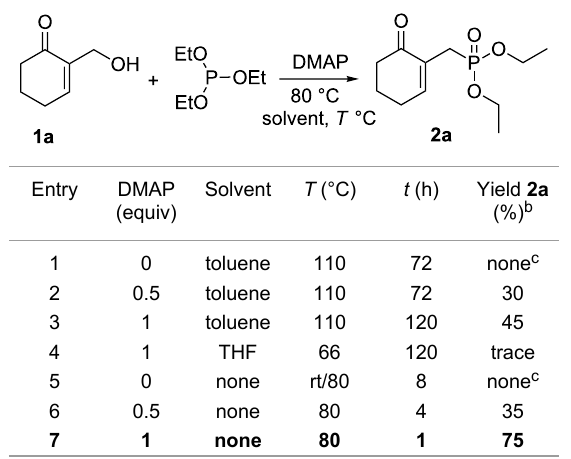
Table 1: Optimization of the reaction conditions for the γ -ketophospho- nate 2a from 1a a